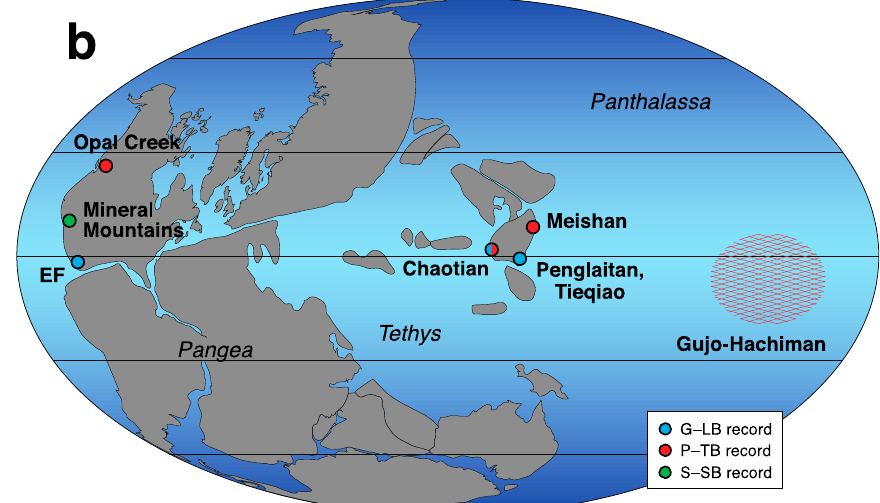
Figure 1. The Permian-Triassic transition interval. ( a ) “triple” extinction during the interval with the ages of the boundaries [47,48]; ( b ) paleo-geographic map [49] with sections of previous multiple sulfur isotope studies. The location of Gujo-Hachiman in mid-Panthalassa is not well constrained. E. Triassic: Early Triassic, M. Tri.: Middle Triassic, W.: Wordian, Wuchiaping.: Wuchiapingian, Chang.: Changhsingian, I.: Induan, Gries.: Griesbachian, D.: Dienerian, Smith.: